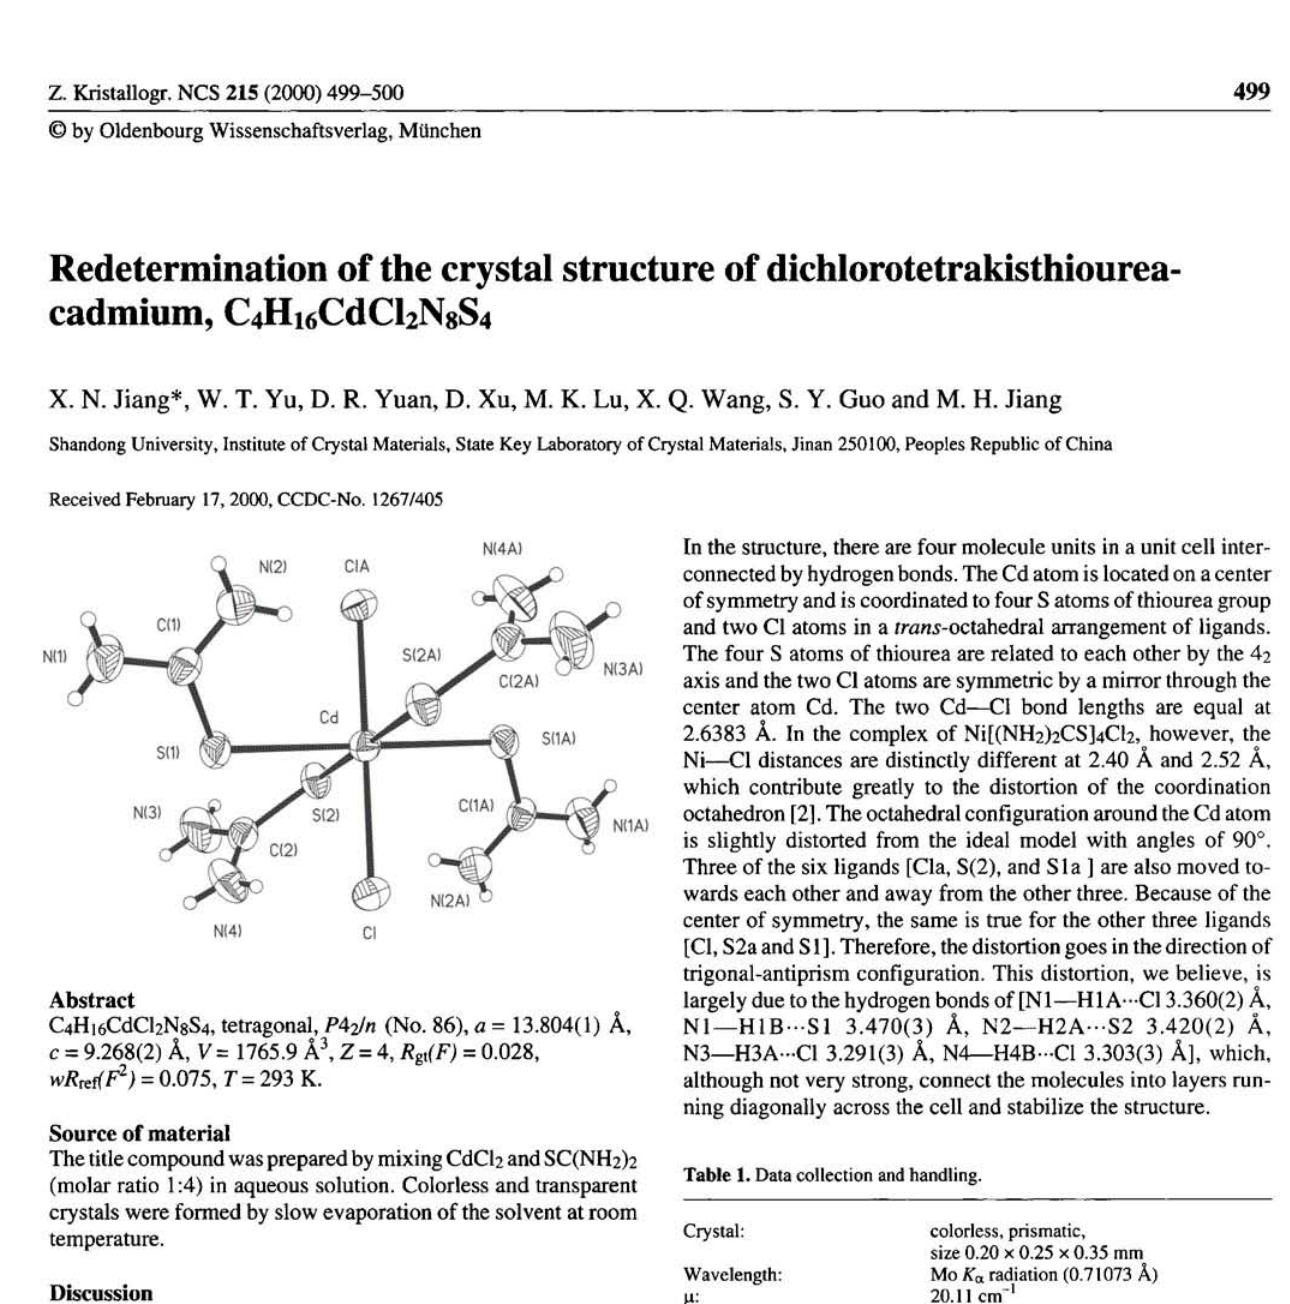
Table 2. Atomic coordinates and displacement parameters (in À